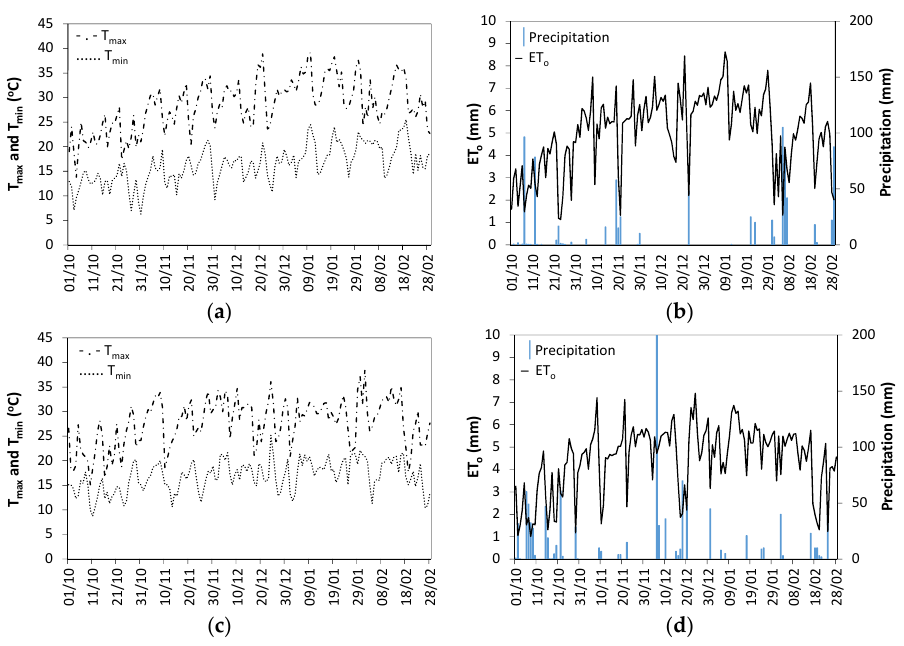
Figure 1. Daily weather data relative to the maize crop seasons of 2011–2012 ( a , b ) and 2012–2013 ( c , d ): Figure 1. maximum and minimum temperatures, T max and T min ( a , c ); precipitation and reference evapotranspiration (ET o ) ( b , d ).